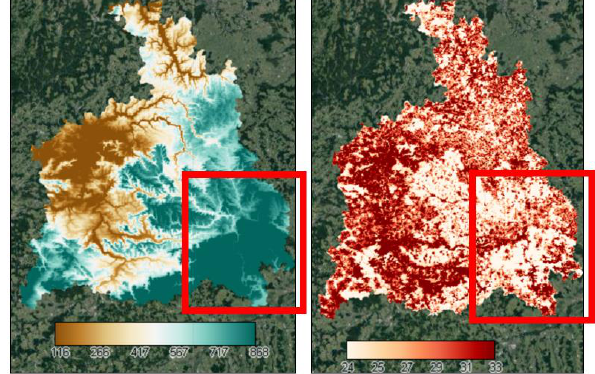
Figure 27: Comparison between the Temperature and DEM values